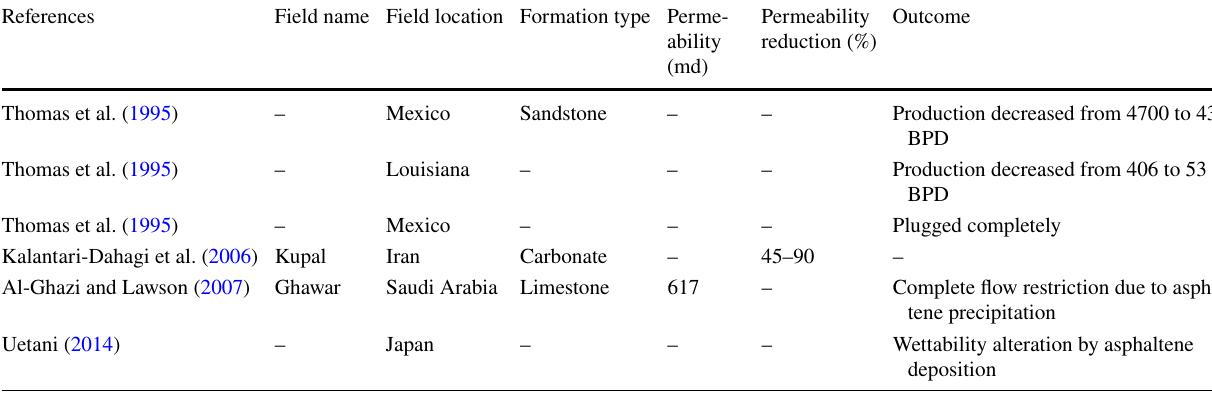
Table 9 Summary of some field cases involving